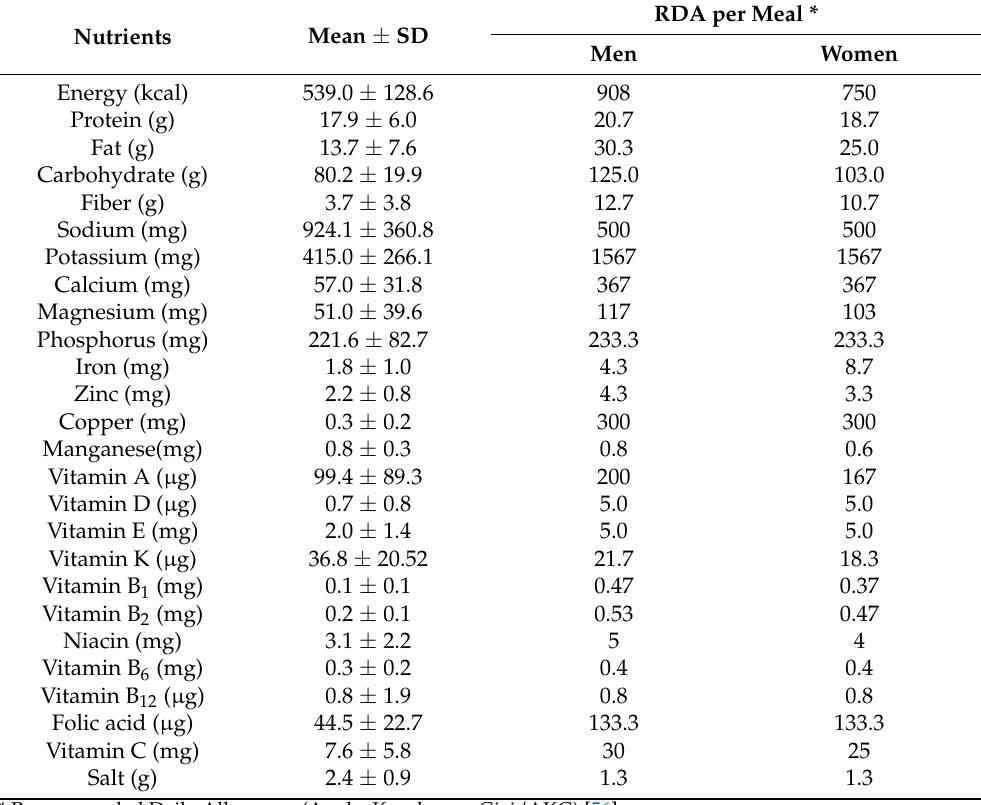
Table 2. The mean nutrition content of the canteen